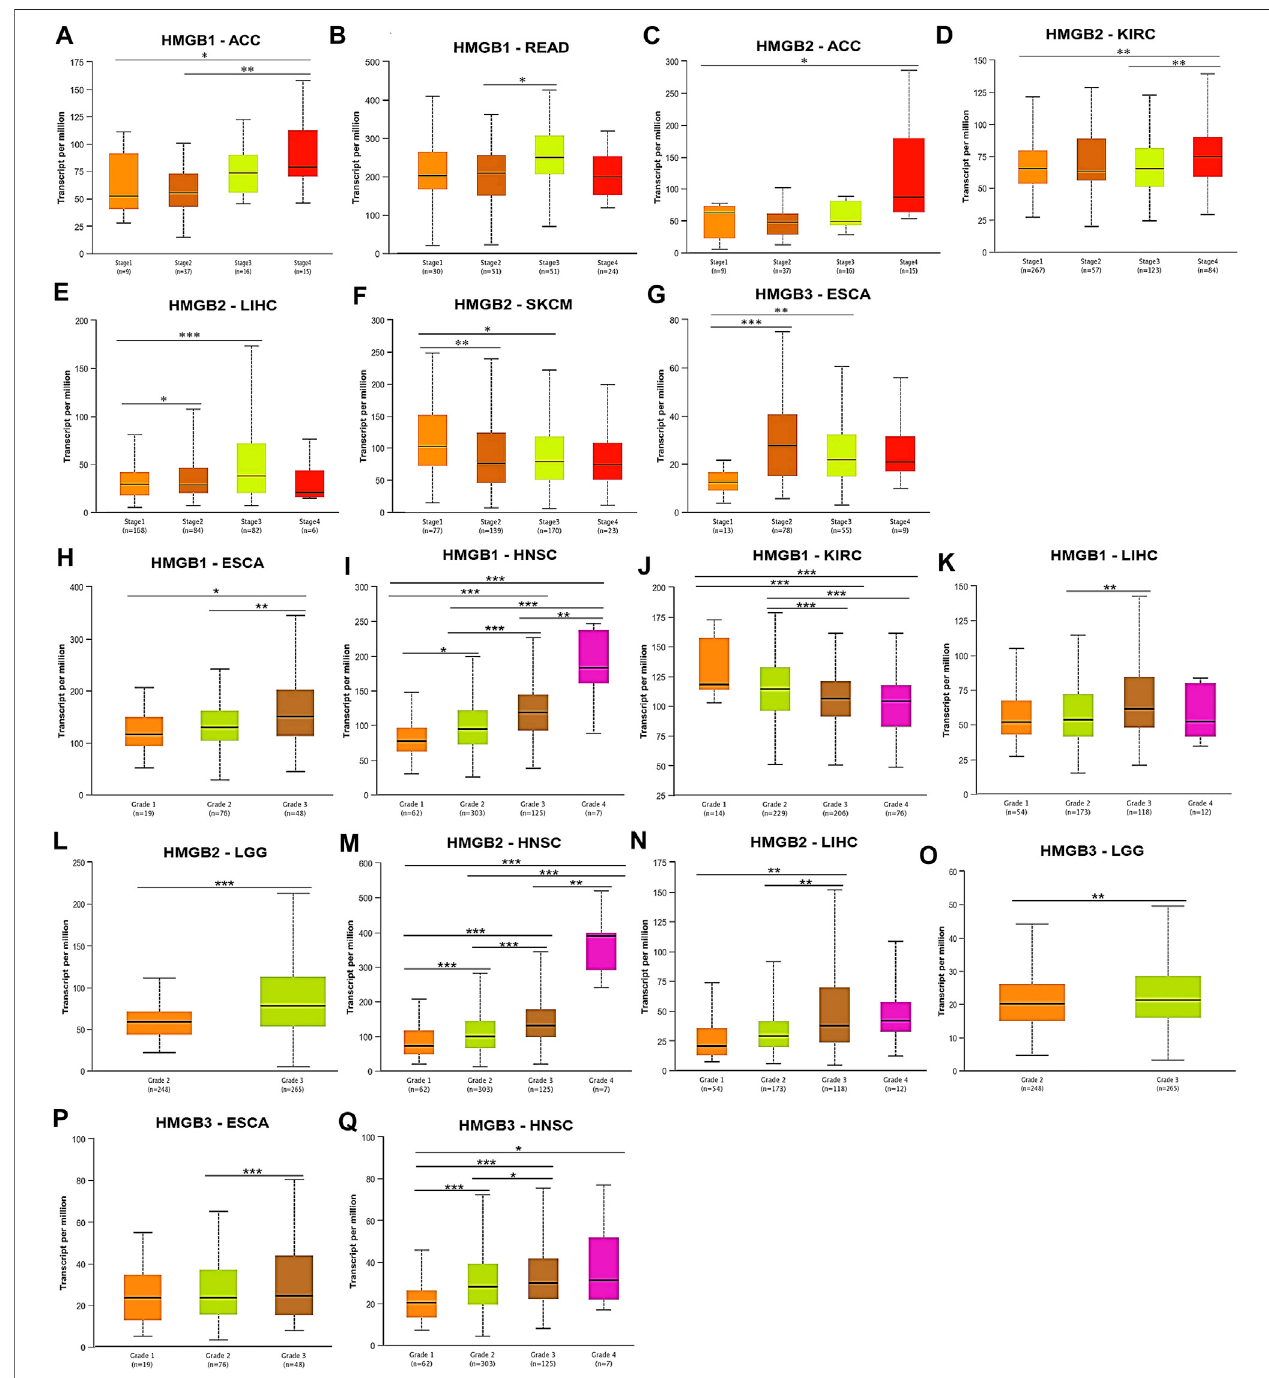
FIGURE 3 | Clinicopathological relevance of High Mobility Group Box (HMGBs) in cancers. Associations of the expression of (A – B) HMGB1, (C – F) HMGB2, and (G) HMGB3 with pathological stages of several cancers. Associations of the expression of (H – K) HMGB1, (L – N) HMGB2, and (O – Q) HMGB3 with tumor grades of several cancers (UALCAN). * p < 0.05, ** p < 0.01, *** p < 0.001.